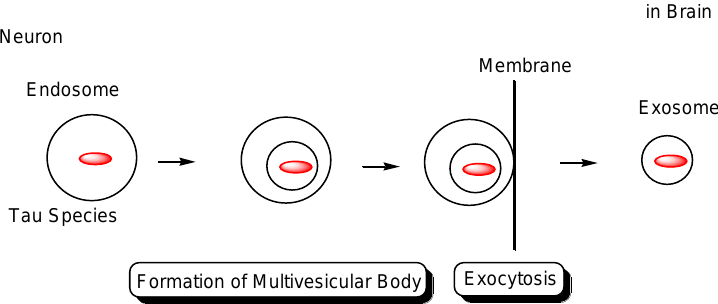
Figure 7. Tau in exosomes (40 – 100 nm in diameter) secreted from neurons.